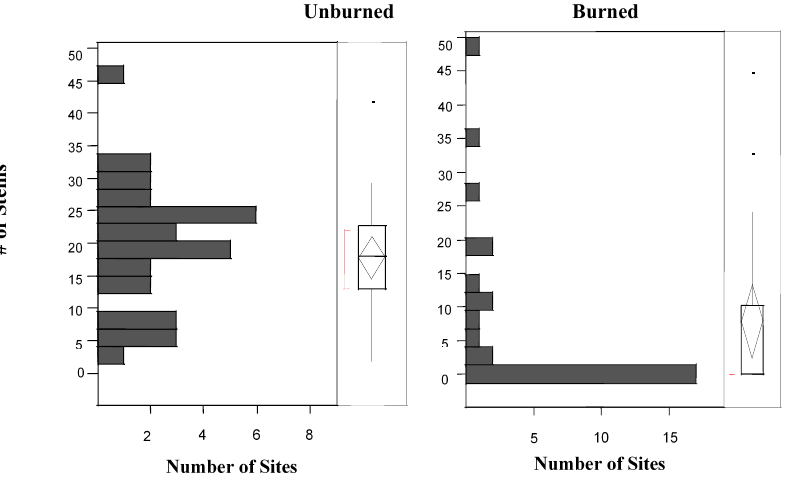
Figure 5. Ponderosa pine frequency (stems/plot) in burned and unburned sites. In the unburned area, ponderosa pine was present at all sites. In the burned area, ponderosa pine was absent in 17 of 30